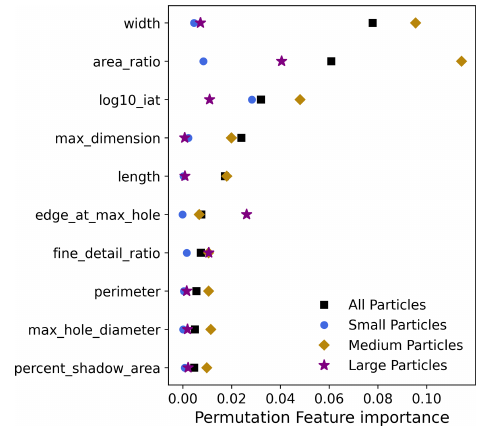
Figure 6. Permutation feature importance for the 10 most important features is shown for all particles (black squares) and for the 3 size classes separately. Features are shuffled 10 times, and the mean fea- ture importance from the 10 trials is shown